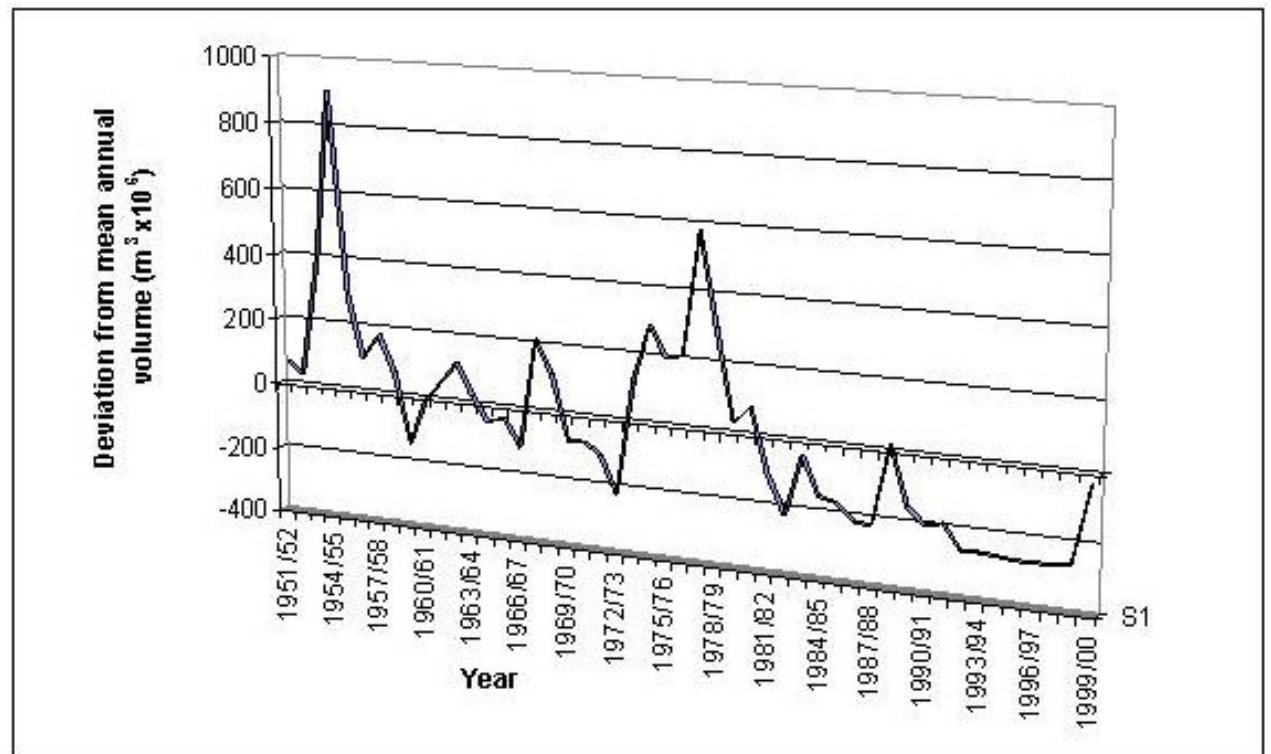
Fig. 4 . Drying of the River Boteti as illustrated by the deviation from the mean annual volume flow (271 m 3 x 10 6 ) at Maun (1951–2000). (Source: Sharing Water Okavango/Kubango database http://www.